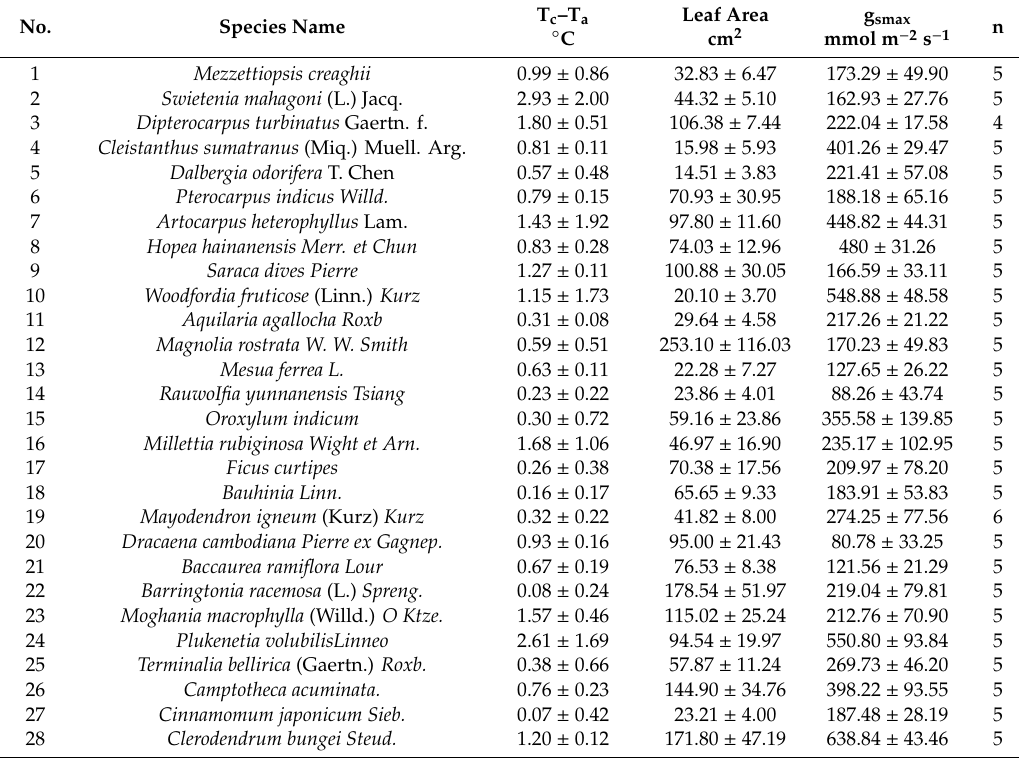
Table 2. Leaf-to-air temperature (Tc – Ta), leaf area, and maximum stomatal conductance (g smax ) of 28 tree species.